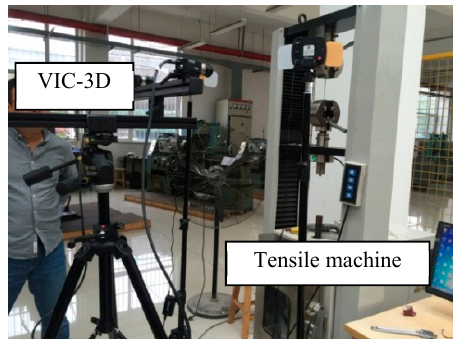
Figure 7. Full field strain experimental platform for tensile test.